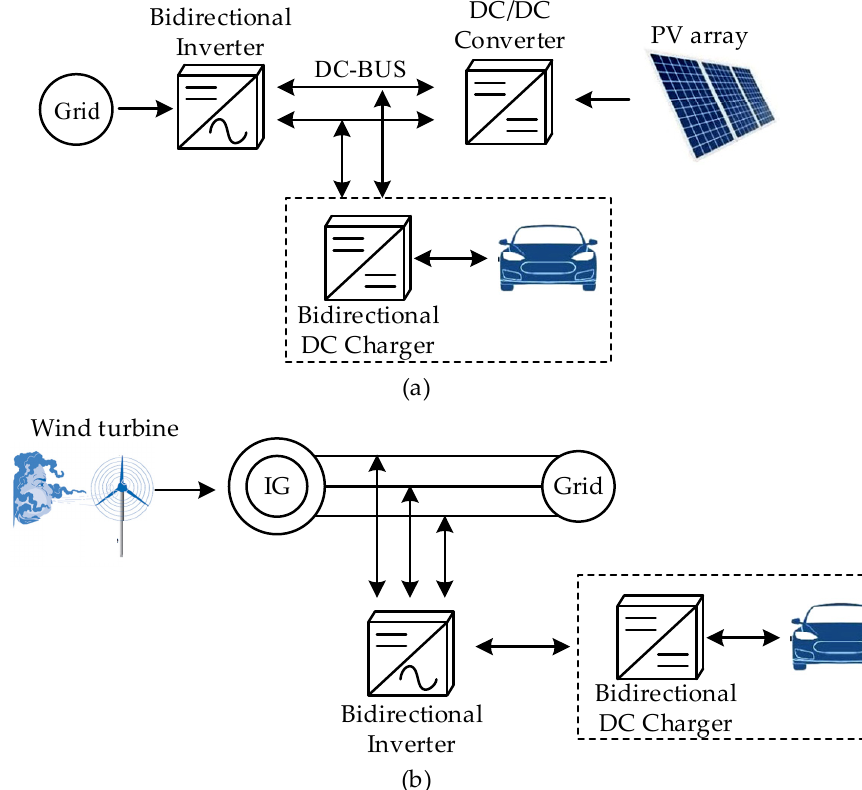
Figure 1. ( a ) EV charging system with PV array and grid, and ( b ) WTG-EV battery charging system. Adapted from [19,20].